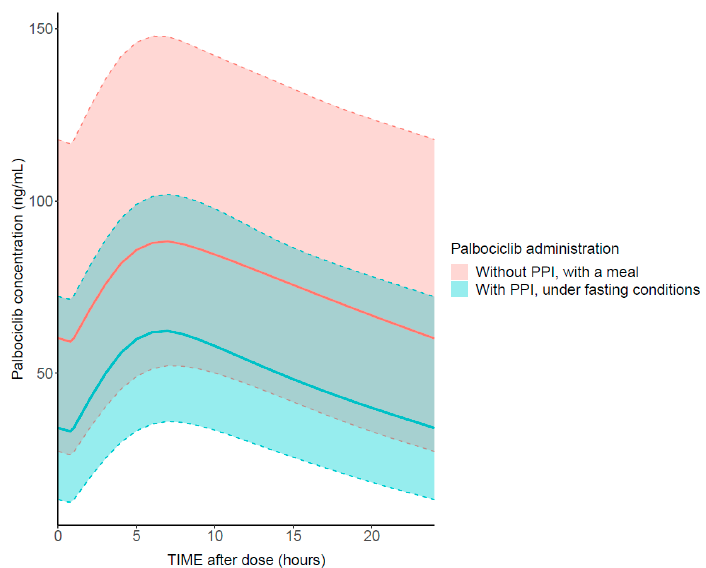
Figure 3. Steady-state palbociclib simulated plasma concentrations in 1000 individuals receiving a standard dose of 125 mg once daily under two different conditions (palbociclib intake with a meal and without PPI versus under fasting conditions with PPI). Continuous lines show the population median prediction, and shaded areas represent the 95% prediction intervals.